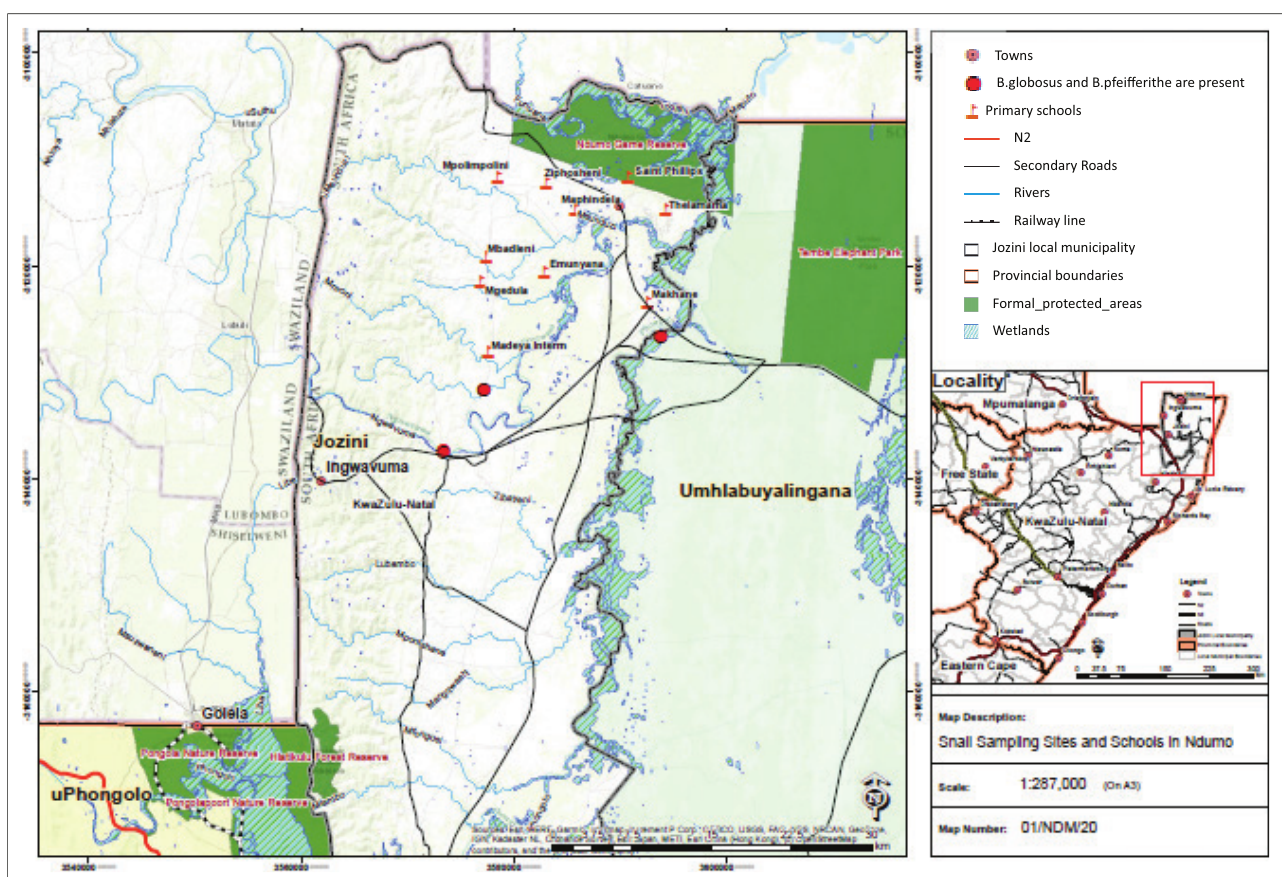
FIGURE 2: Map showing the location of Ingwavuma in the province of